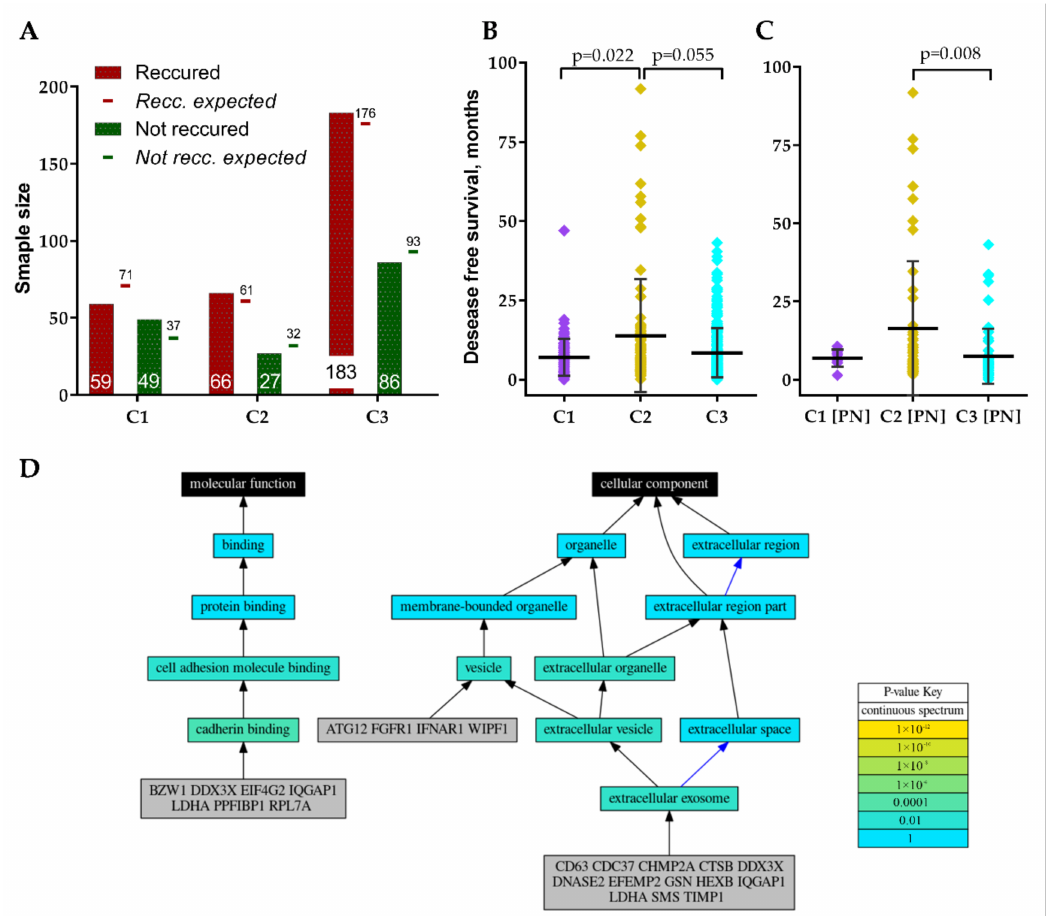
Figure 5. ( A ) Recurred and not recurred samples distribution in clusters. ( B ) GBM patients’ disease-free survival distribution in clusters. ( C ) Proneural subtype patients’ disease-free survival distribution in clusters. ( D ) Schematic visualization of GO analysis results of GSC signature